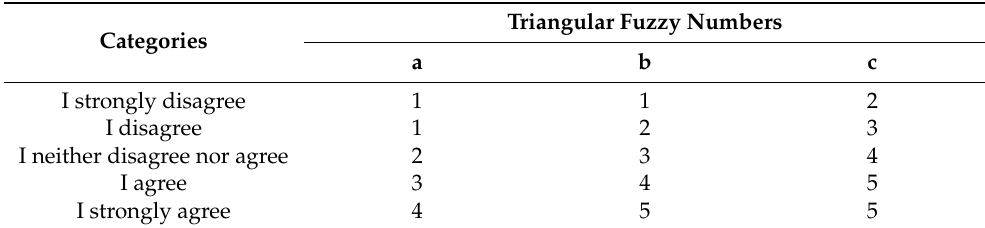
Table 1. Parameters of the triangular fuzzy numbers for the fuzzy conversion scale.